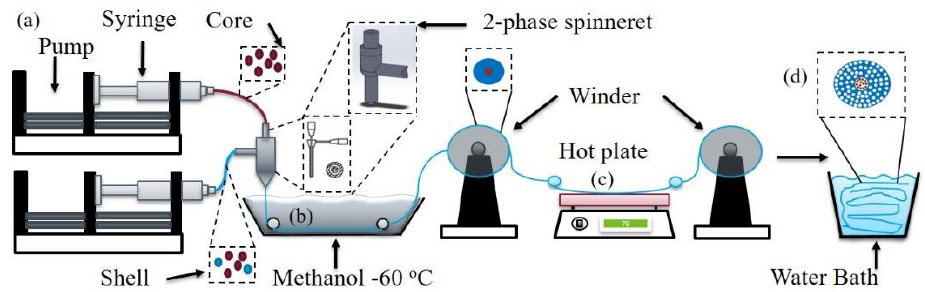
Figure 1. ( a ) Dry-jet wet-spinning of solution injection via an in-house designed two-phase spinneret, ( b ) coagulation, ( c ) heat treatment on the hot plate, and ( d ) porogen agent dissolution and pore